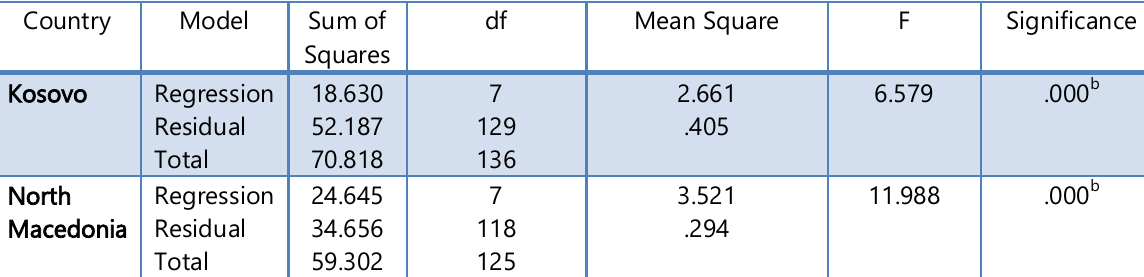
Table 3: ANOVA (Source: Authors‟ depiction)